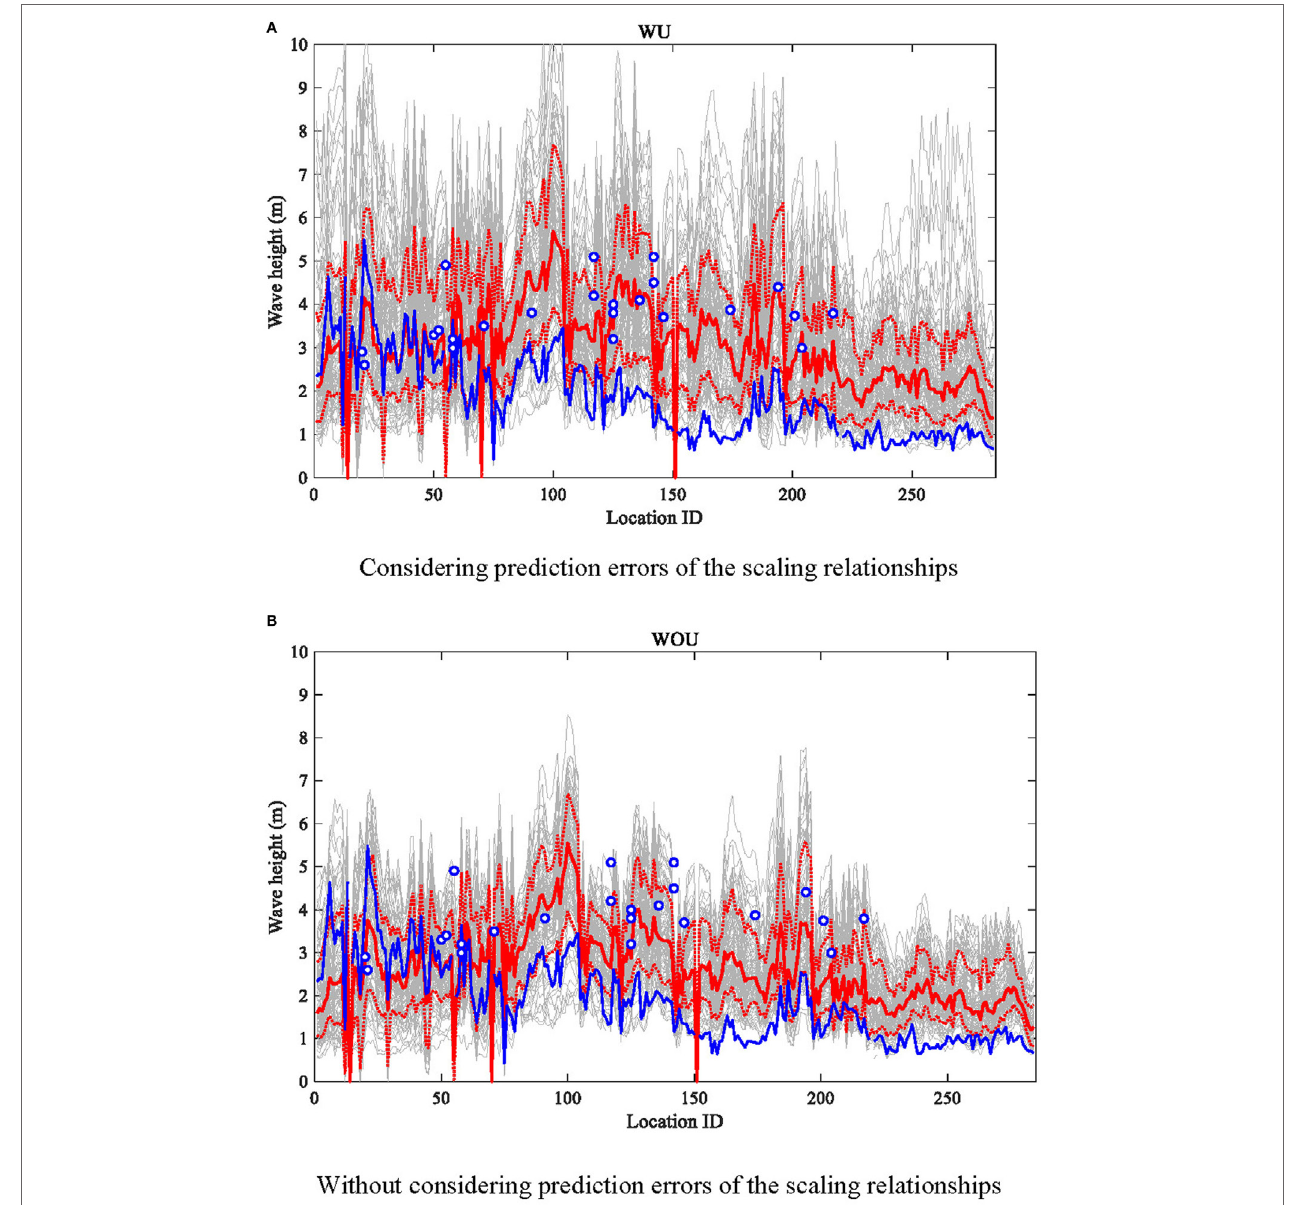
FigUre 12 | Maximum tsunami wave height profile along the coastal line for the stochastic models with and without considering prediction errors of the scaling relationships [red solid line: mean, red dashed line: upper and lower 16%, gray line: individual stochastic run, blue solid line: historical run, circle: observed run-up height by Trejo-Gómez et al. (2015)]. (a) Considering prediction errors of the scaling relationships. (B) Without considering prediction errors of the scaling